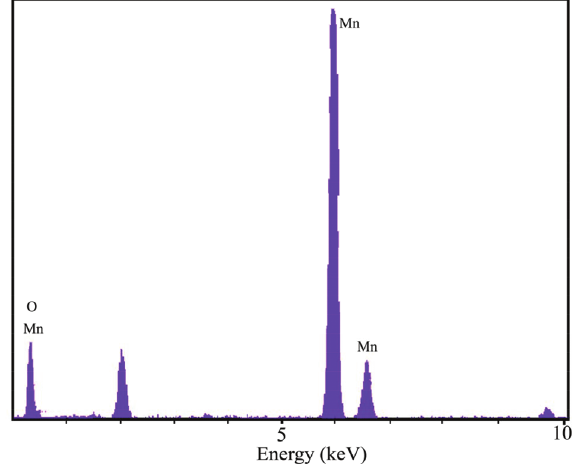
Figure 6: TEM image of sample no. 1.